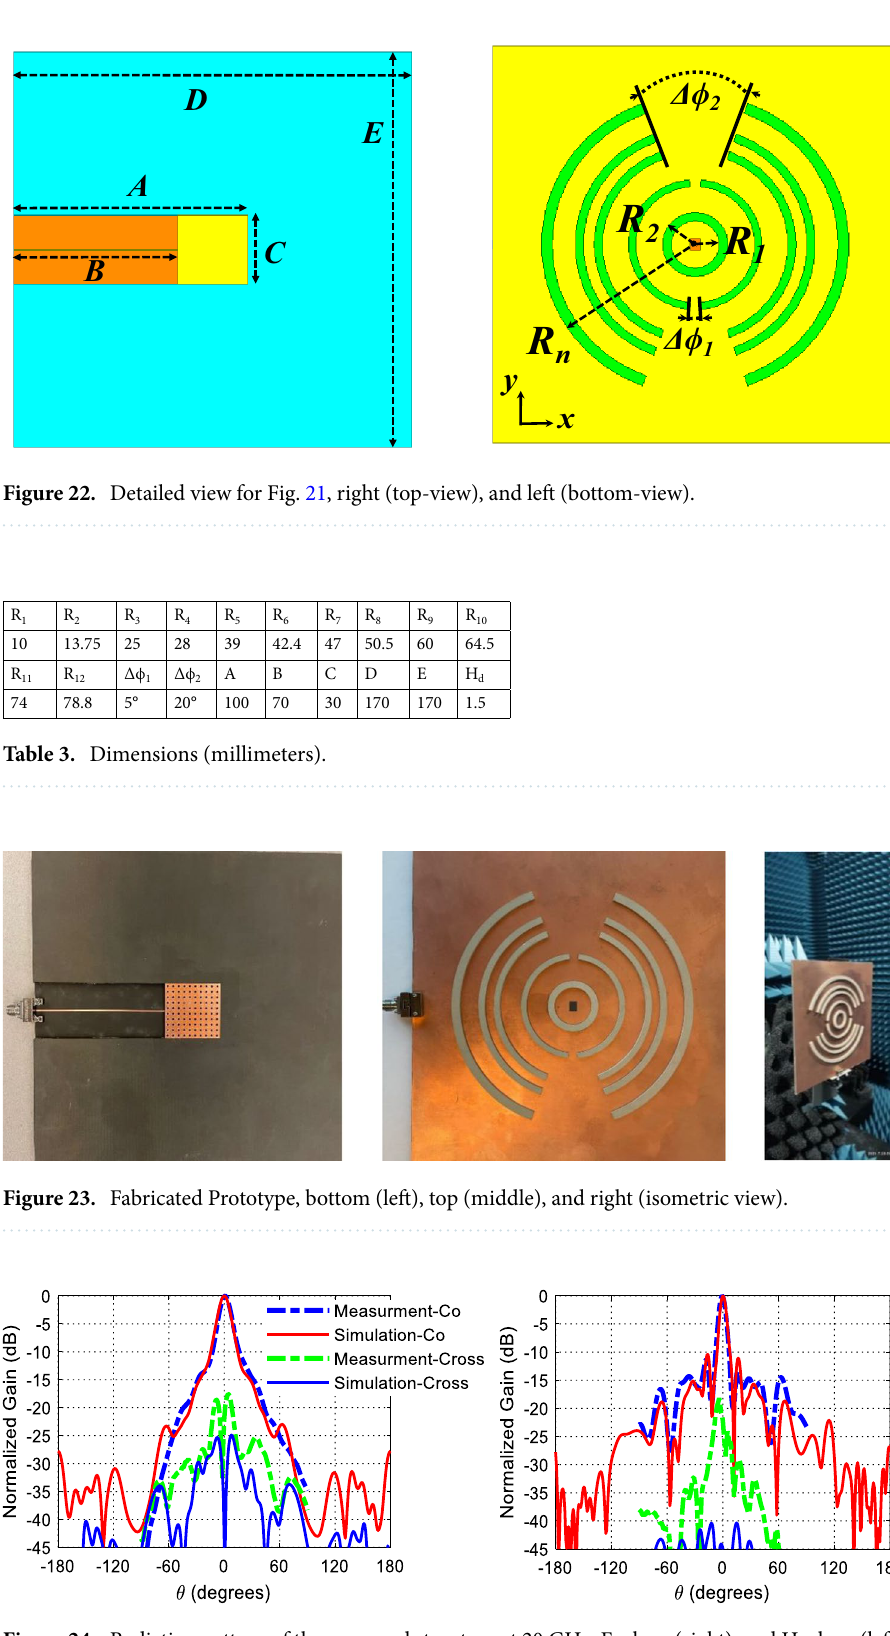
Figure 24. Radiation pattern of the proposed structure at 20 GHz, E-plane (right), and H-plane